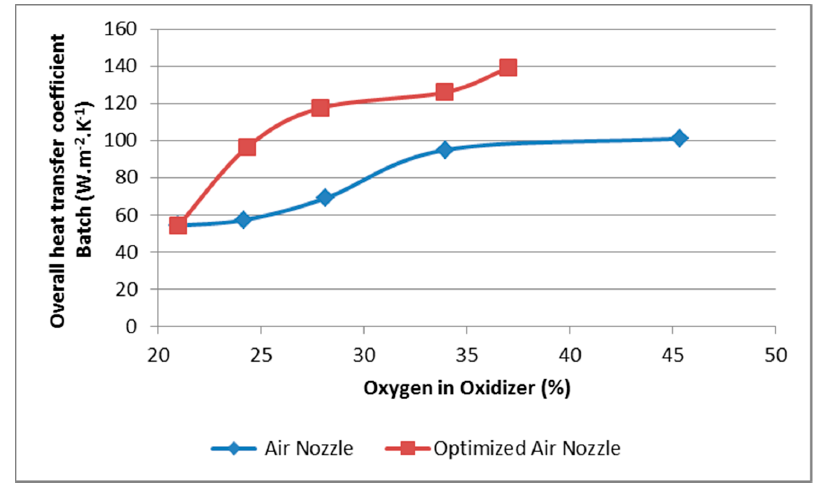
Figure 12. Heat flux density depending on the oxidizer oxygen concentration for the ordinary and optimised air nozzles (calculated on the basic of the measurement results). Appl. Sci. 2019 , 9 , x FOR PEER REVIEW